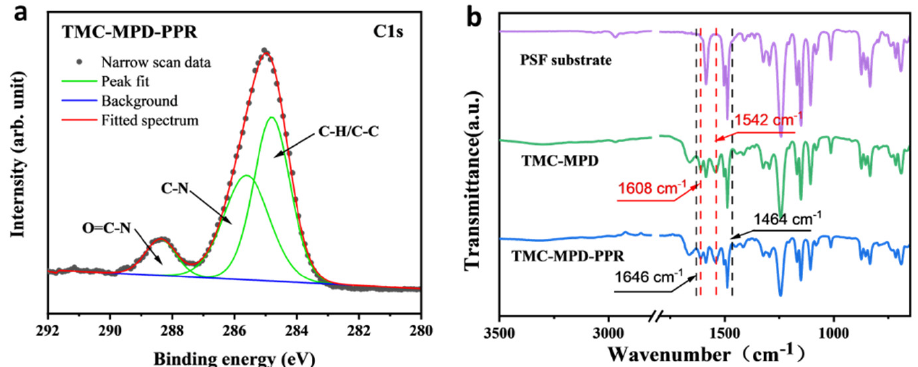
Figure 2. Chemical composition of the fabricated RO membranes. ( a ) C1s XPS spectra of the membranes; ( b ) ATR-FTIR spectra of the PSF support and prepared RO membranes; the concentration of PPR for modified RO membrane was 1.0%.